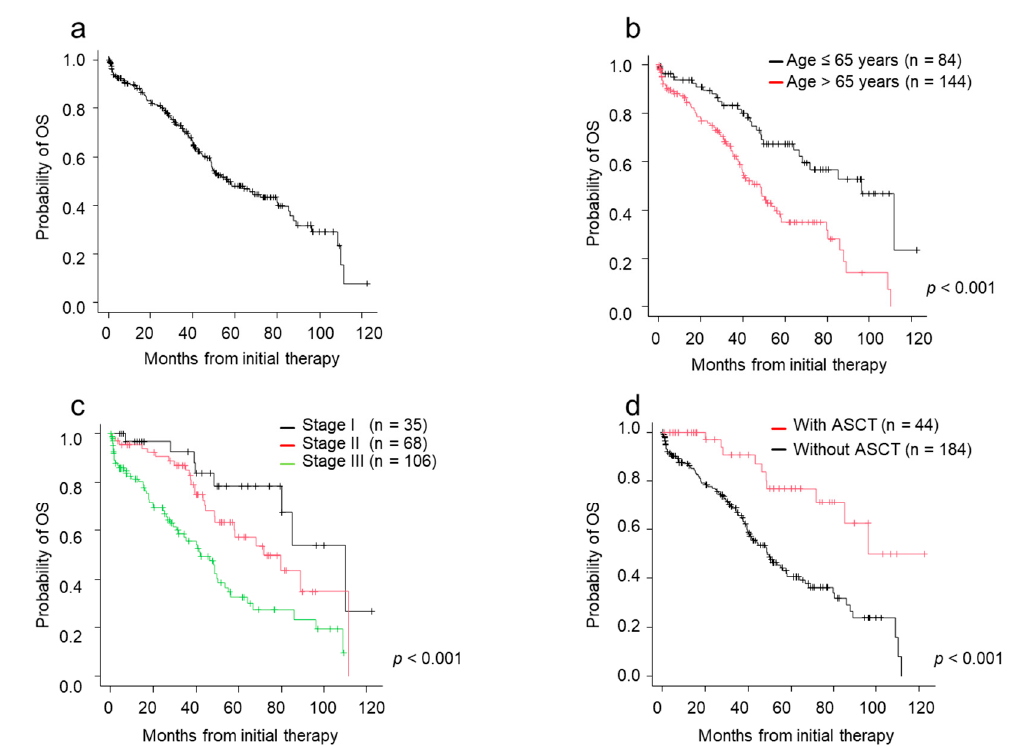
Figure 2. Overall survival (OS) by patient characteristics and type of therapies. ( a ) OS from initial therapy. ( b ) OS from initial therapy by age. ( c ) OS from initial therapy by ISS stage. ( d ) OS from initial therapy by ASCT status. ASCT, autologous stem cell transplantation; ISS, International Staging System; OS, overall survival.